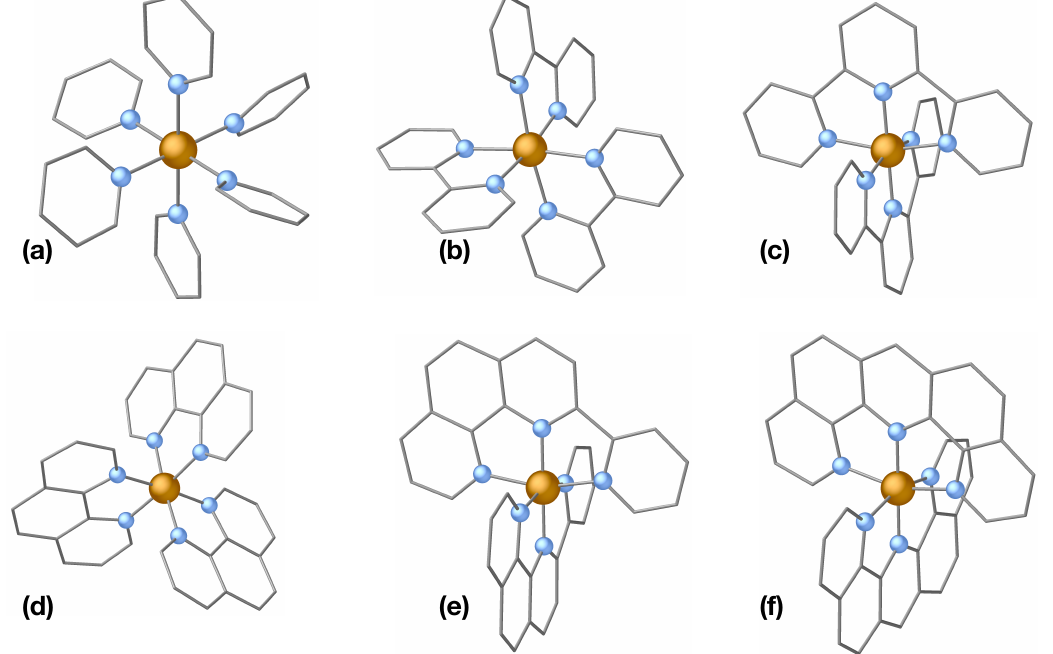
Figure 3. Six Fe(II) complexes with increasing π -conjugation on the ligand. a = [Fe(py) 6 ] 2 + , b = [Fe(bpy) 3 ] 2 + , c = [Fe(terpy) 2 ] 2 + , d = [Fe(phen) 3 ] 2 + , e = [Fe(dipphen) 2 ] 2 + , f = [Fe(acri) 2 ] 2 + . py = pyridine; bpy = bipyridine; terpy = terpyridine; phen = phenantroline; dipphen = 2-(2-pyridyl)-1,10-phenanathroline; acri = dipyrido-[4,3-b;5,6-b]